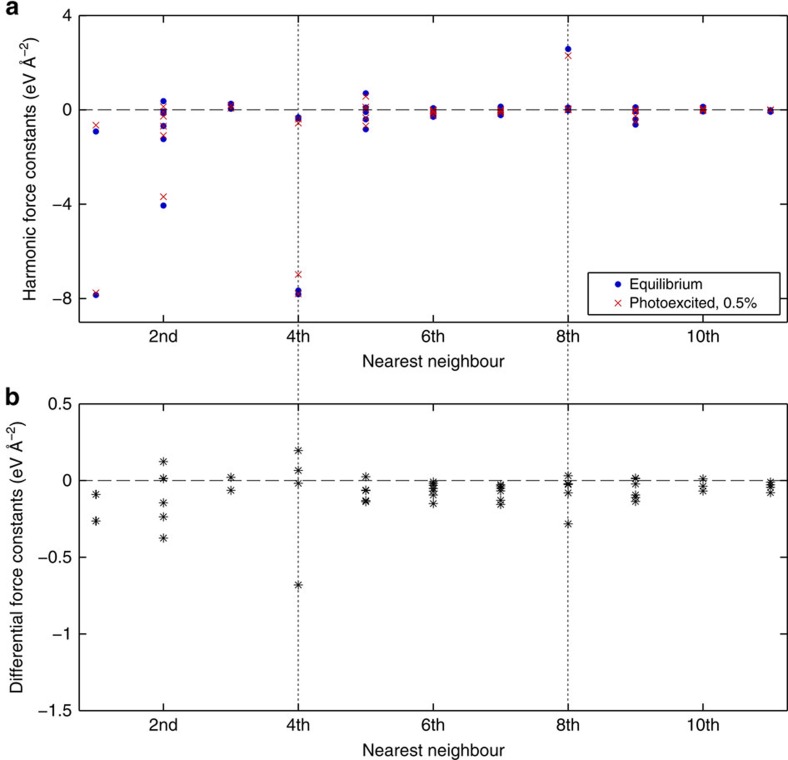
Comparison of calculated harmonic interatomic force constants at equilibrium and under 0.5% photoexcitation.(a) Nonzero harmonic interatomic force constants (IFCs) calculated for both equilibrium (blue dots) and 0.5% photoexcited PbTe (red crosses) on 216-atom supercells. The IFCs for the first eleven nearest neighbouring atoms are displayed. Particularly large IFCs are observed between first, fourth and eighth nearest neighbours, which correspond to interactions along the <100> bonding direction responsible for PbTe's incipient ferroelectricity. See Fig. 6 for a real-space depiction of these neighbours. The absolute values of these large IFCs notably decrease with photoexcitation, driving PbTe further away from the ferroelectric phase. (b) Differences between the absolute values of the equilibrium and photoexcited IFCs in a.